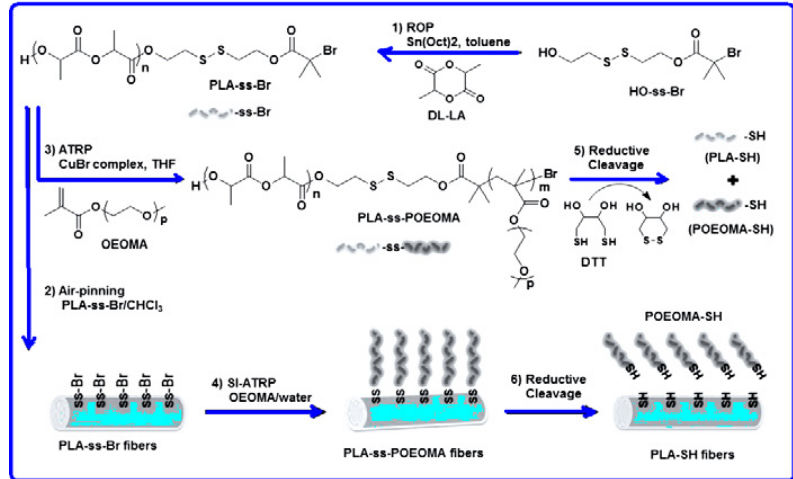
Figure.5 . Illustration of the method to synthesize PLA ― ss ― POEOMA nano ― fibers by surface ― initiated atom transfer radical Fig. 5 . Illustration of the method to synthesize PLA - ss - POEOMA nano - fibers by surface - initiated atom transfer radical polymerization polymerization of OEOMA in the presence of PLA ― ss ― Br fibrous macro ― initiators and their degradation in response to of OEOMA in the presence of PLA - ss - Br fibrous macro - initiators and their degradation in response to reductive reductive reactions[18].